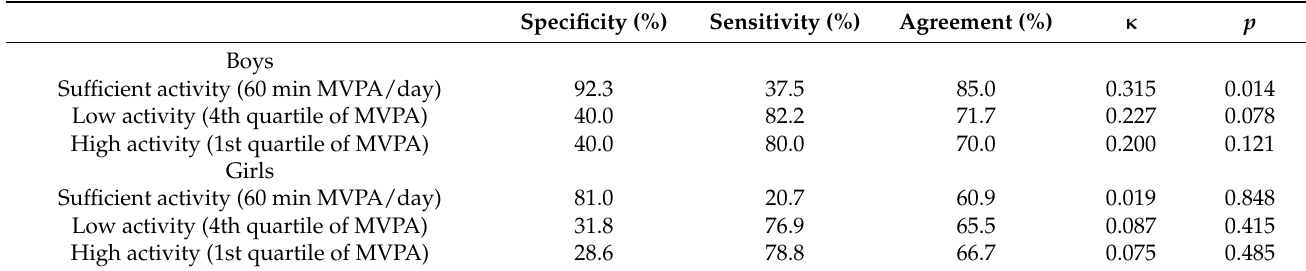
Table 3. Agreement between the questionnaire-based and SWA-based categorization of female and male adolescents as sufficiently active based on current health recommendations, as well as the most active quartile and the least active quartile according to MVPA determined using percent agreement and Kappa